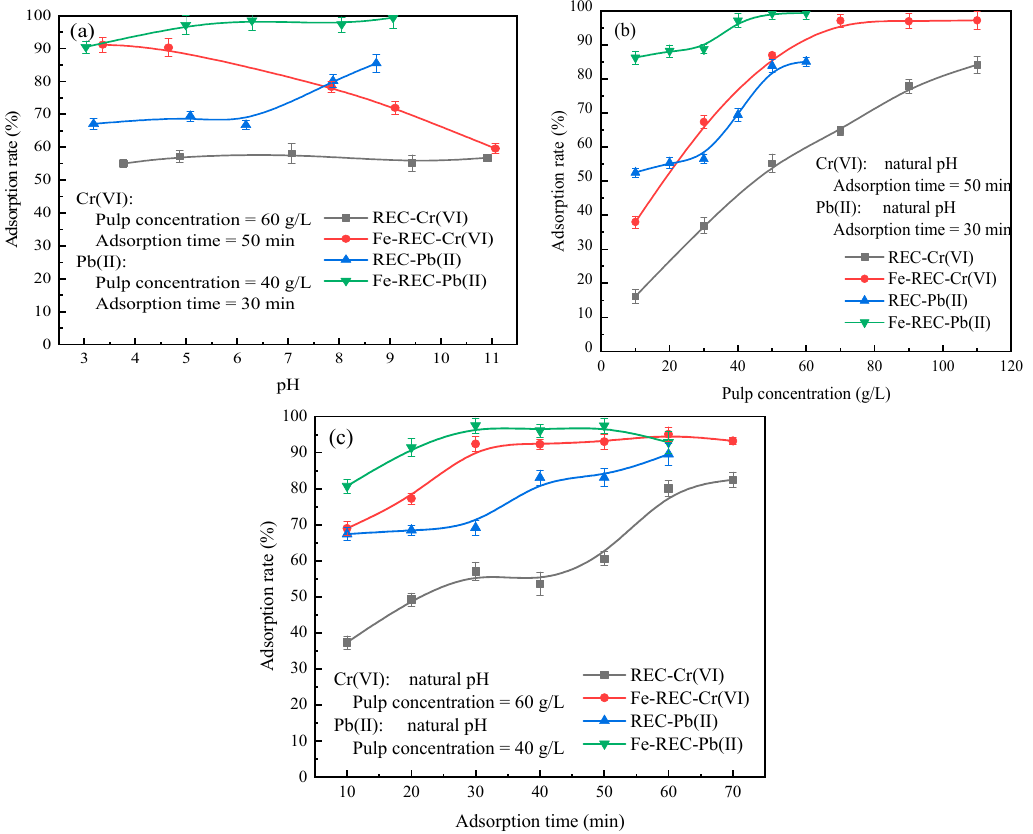
Figure 4. The effect of three different factors on Cr( Ⅵ ) and Pb(II) adsorption with REC and Fe-REC. ( a ) pH; ( b ) pulp concentration and ( c ) adsorption time.